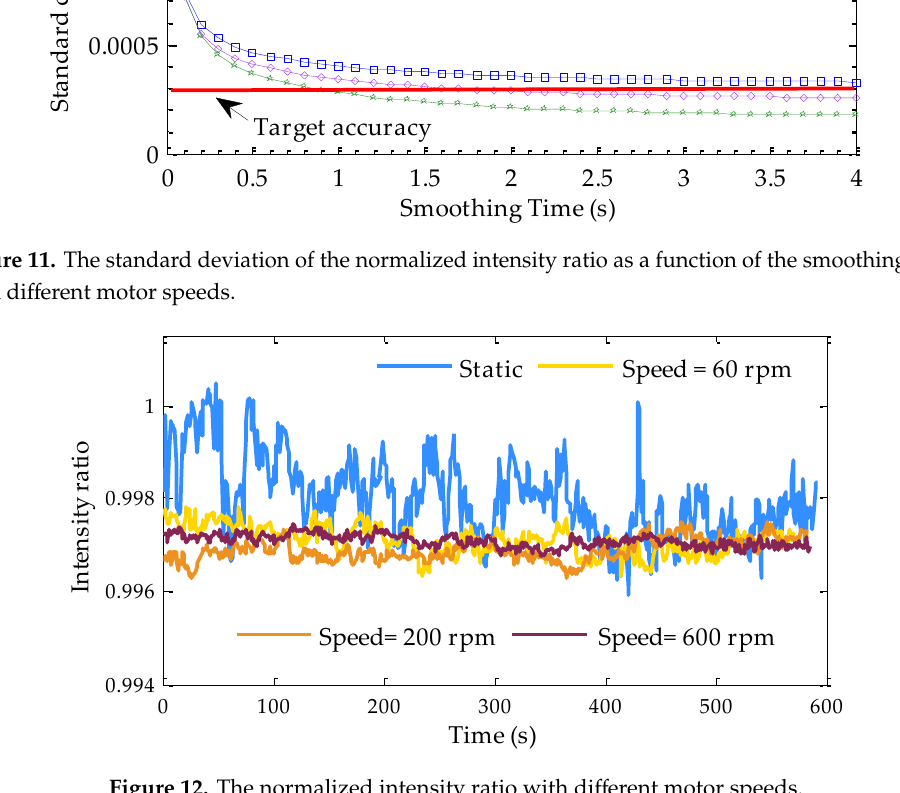
Figure 12. The normalized intensity ratio with di ff erent motor speeds. Table 2. Correlation coe ffi cients of the normalized intensities between the on and o ff wavelengths with di ff erent motor